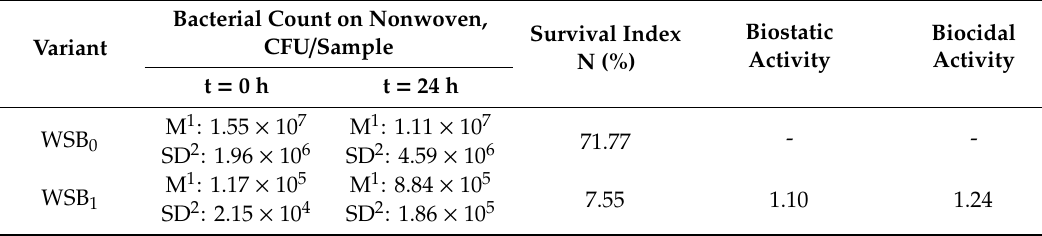
Table 7. S. aureus counts on the studied nonwoven variants as well as survival index and microbial activity. Bacterial Count on Nonwoven, Biostatic Survival Index CFU / Sample Variant Activity N (%)